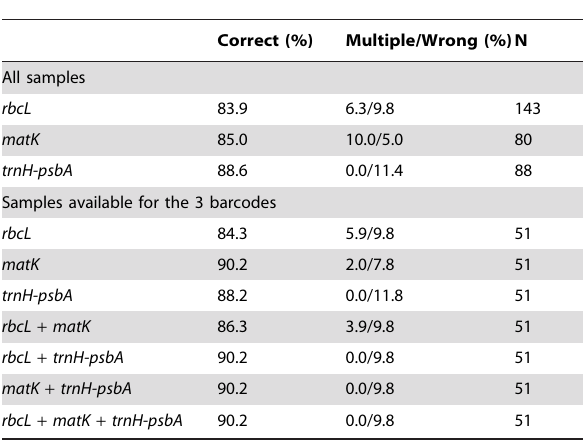
Table 4. Barcoding success of African rain forest trees at the regional scale for genus identification using the PI